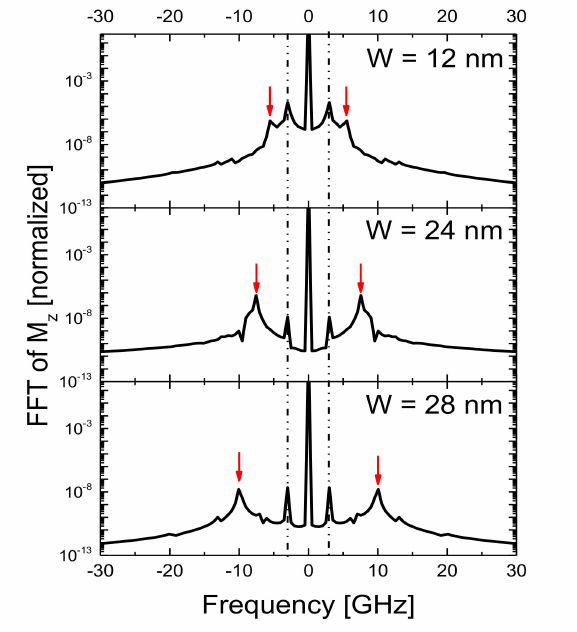
Figure 5. M z spectra resulting from changing W (nm), for 8–10 ns time window. Dashed lines are an indication of the excitation frequency for three